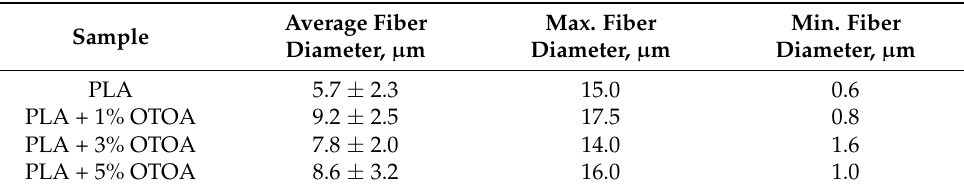
Table 1. Average, maximum and minimum fiber diameters for the nonwoven PLA fiber mats with different amounts of added